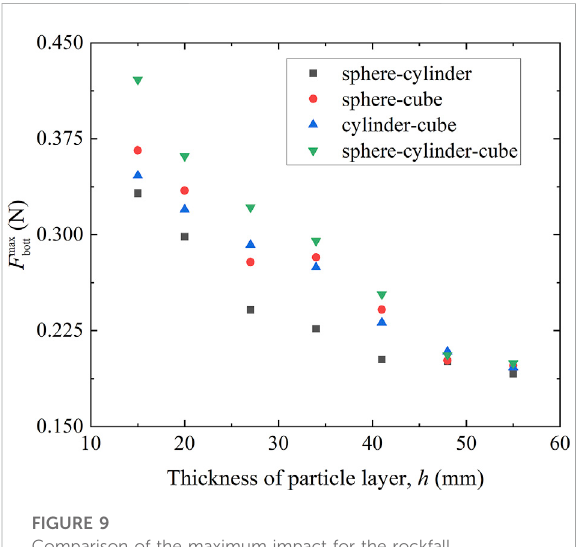
FIGURE 9 Comparison of the maximum impact for the rockfall impacting against the granular material of buffering with different thickness of soil cushion